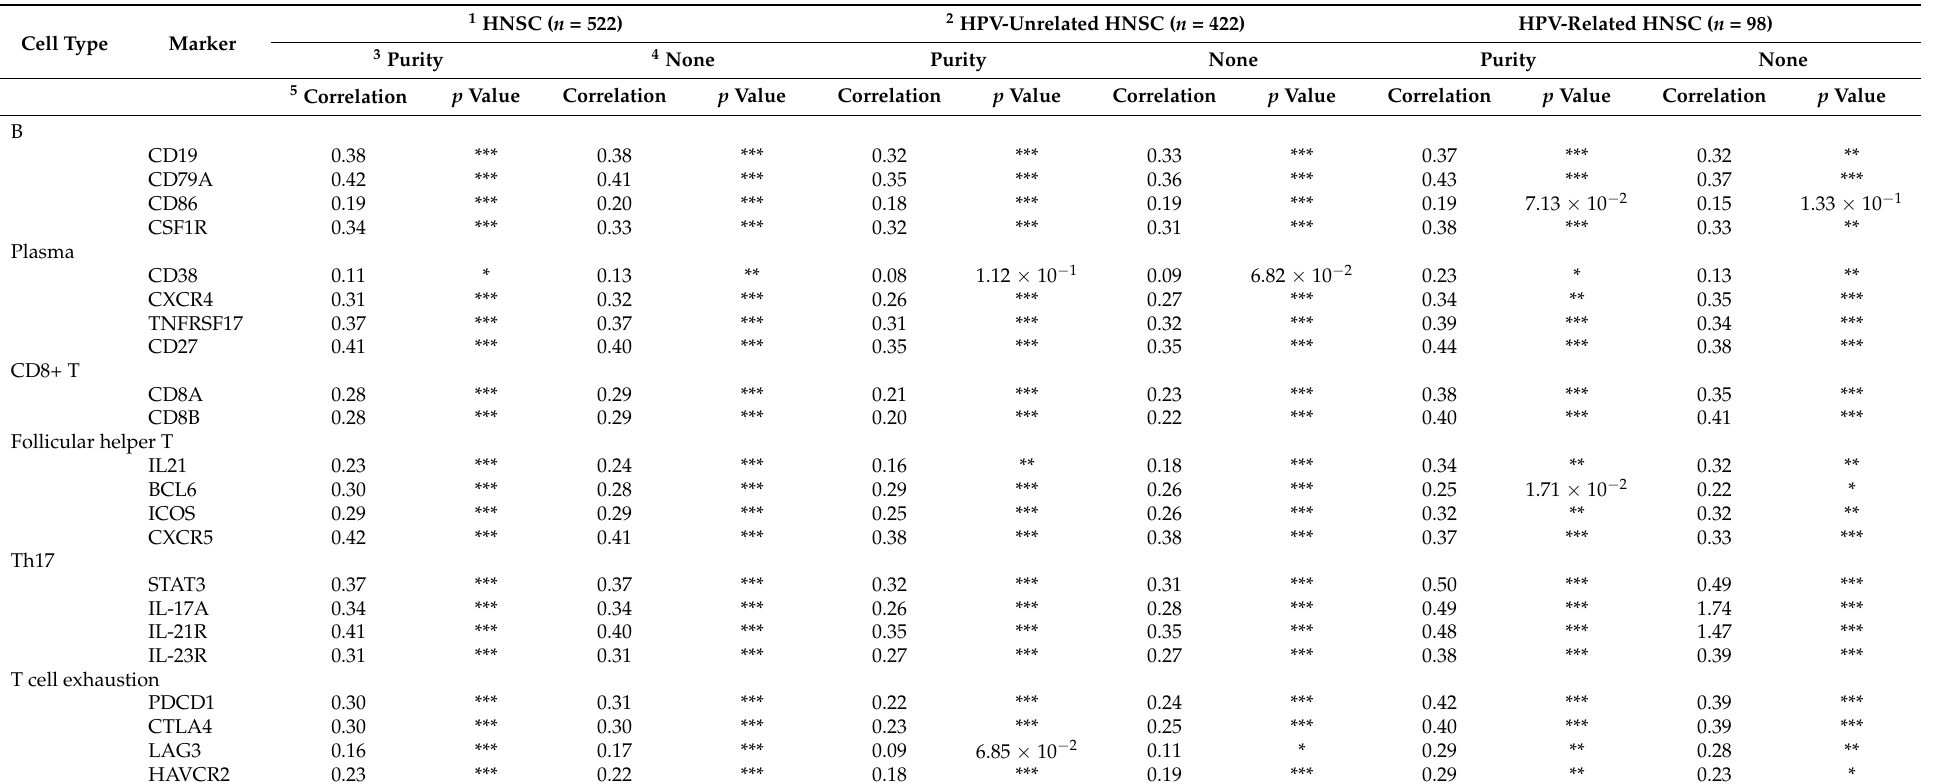
Table 2. Associations between FCGBP level and gene markers in tumor-infiltrating immune cells in HNSC by HPV infection status. Cell